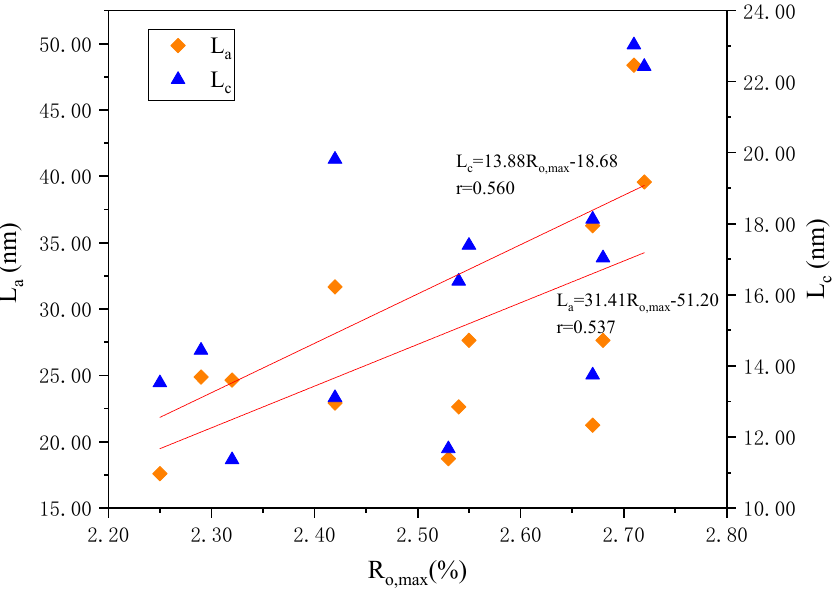
Figure 4. Scatter diagram of L a and L c of coal-based graphite.